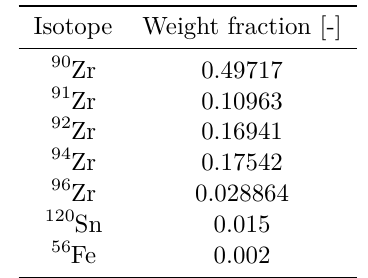
Table 2. Zircaloy-4 isotopic